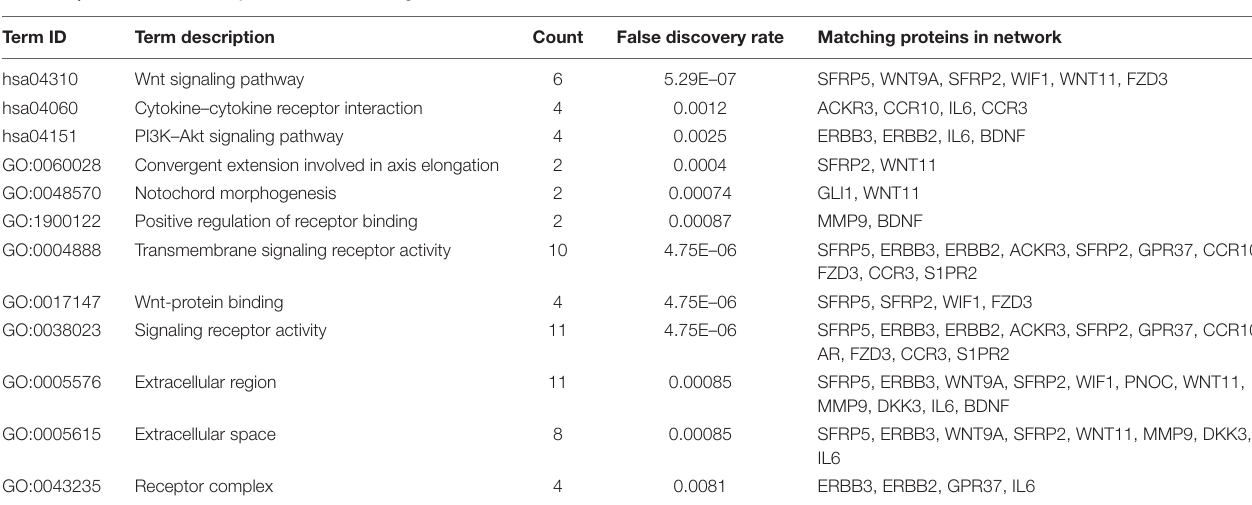
TABLE 2 | The enrichment analysis of candidate hub